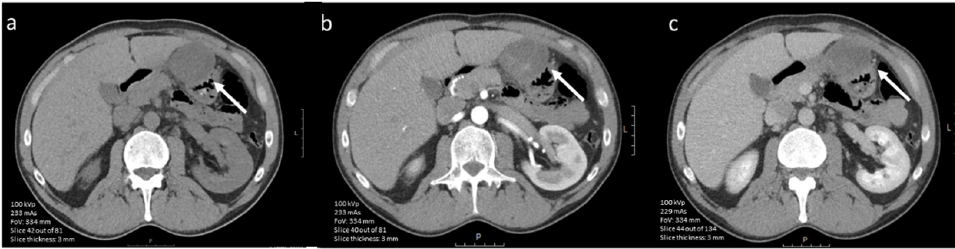
Figure 3. ( a – c ) . Axial contrast-enhanced (iodinated contrast media) CT image of a 45-year-old male diagnosed with a (histopathologically confirmed) low mitotic gastric GIST. The lesion (arrow) shows a round tumor shape and homogeneous enhancement in ( a ) nonenhanced phase, ( b ) arterial phase and ( c ) portal venous phase (scale bars 5 cm).